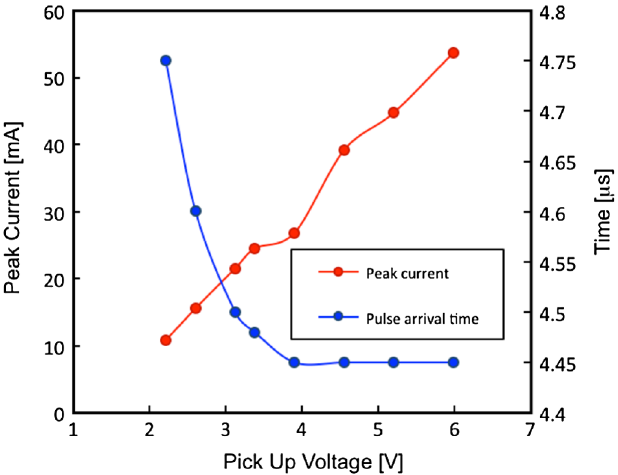
FIG. 37. Analyzed output current on channel 1 as a function of the pickup voltage (extraction voltage: 30 kV; plasma input position: 6